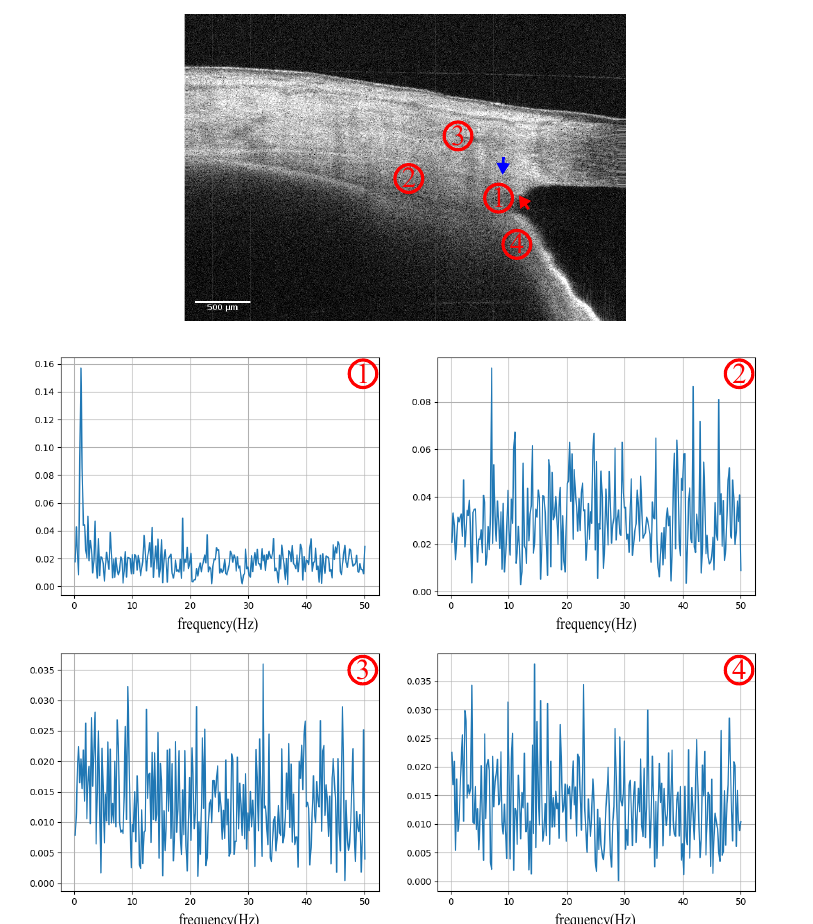
Figure 3. Frequency spectrum of the PhDiff signal sampled on the iridocorneal angle, including 1 (cid:13) : the trabecular meshwork and Schlemm’s canal adjacent region; 2 (cid:13) : the ciliary body region; 3 (cid:13) : the corneal region; and 4 (cid:13) : the iris region. The red arrow points to the trabecular meshwork, and the blue arrow points to the SC. The unit of the horizontal axis of the frequency spectrum graphic is Hertz.